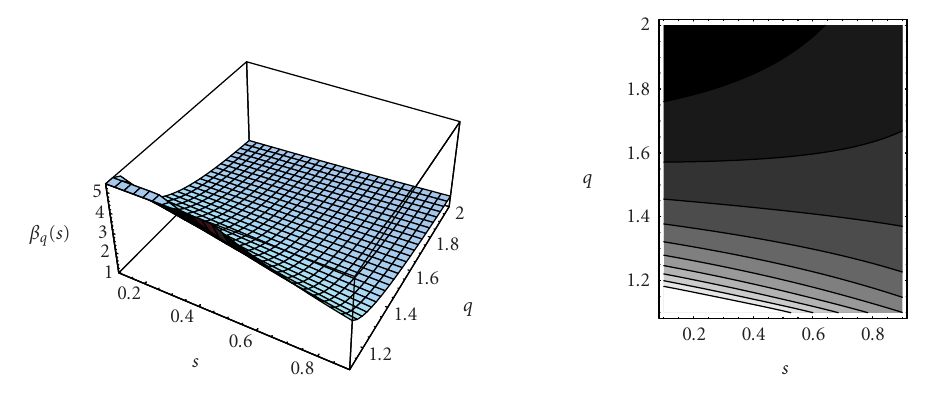
Figure 4.1. The plot of β q ( s ), 0 . 1 ≤ s ≤ 0 . 9, 1 . 1 ≤ q ≤